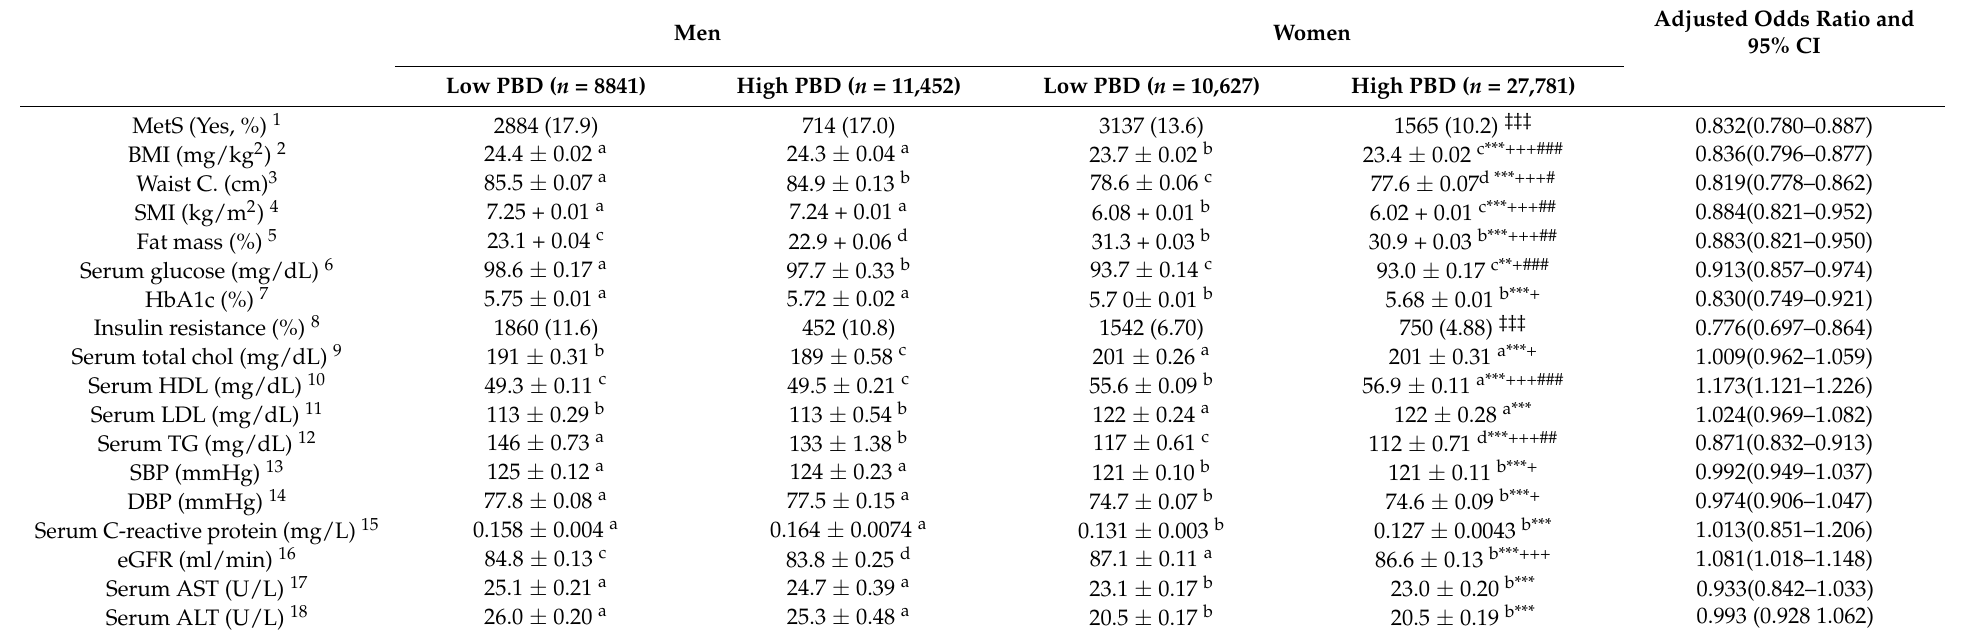
Adjusted Odds Ratio